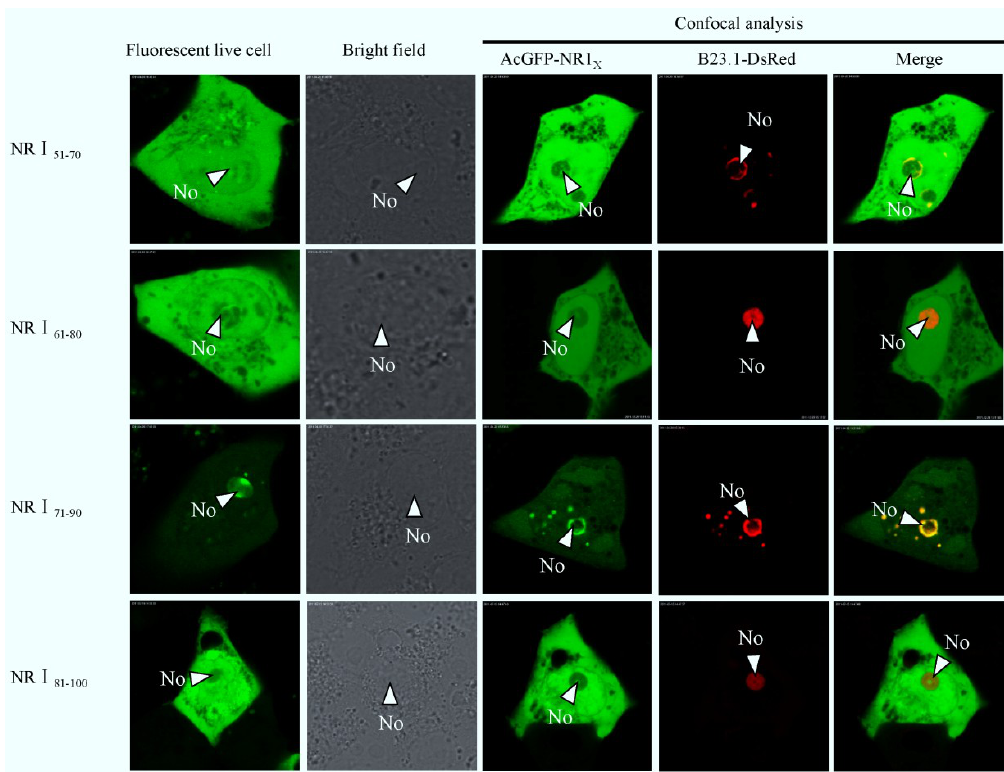
Figure 5. Live cell and confocal microscopy of the sub-cellular localization of fluorescent fusion proteins: AcGFP-NR1 , AcGFP-NR1 , AcGFP-NR1 , AcGFP-NR1 . 51–70 61–80 71–90 81–100 The PEDV fusion peptides are colored green and the B23.1 fusion protein colored red. Merged images are also presented. The nucleolus (No) is arrowed where